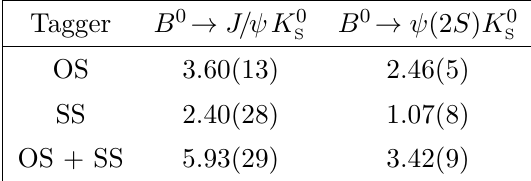
Table 1 . E(cid:11)ective (cid:13)avour-tagging e(cid:14)ciencies in per cent of the SS and OS taggers and their